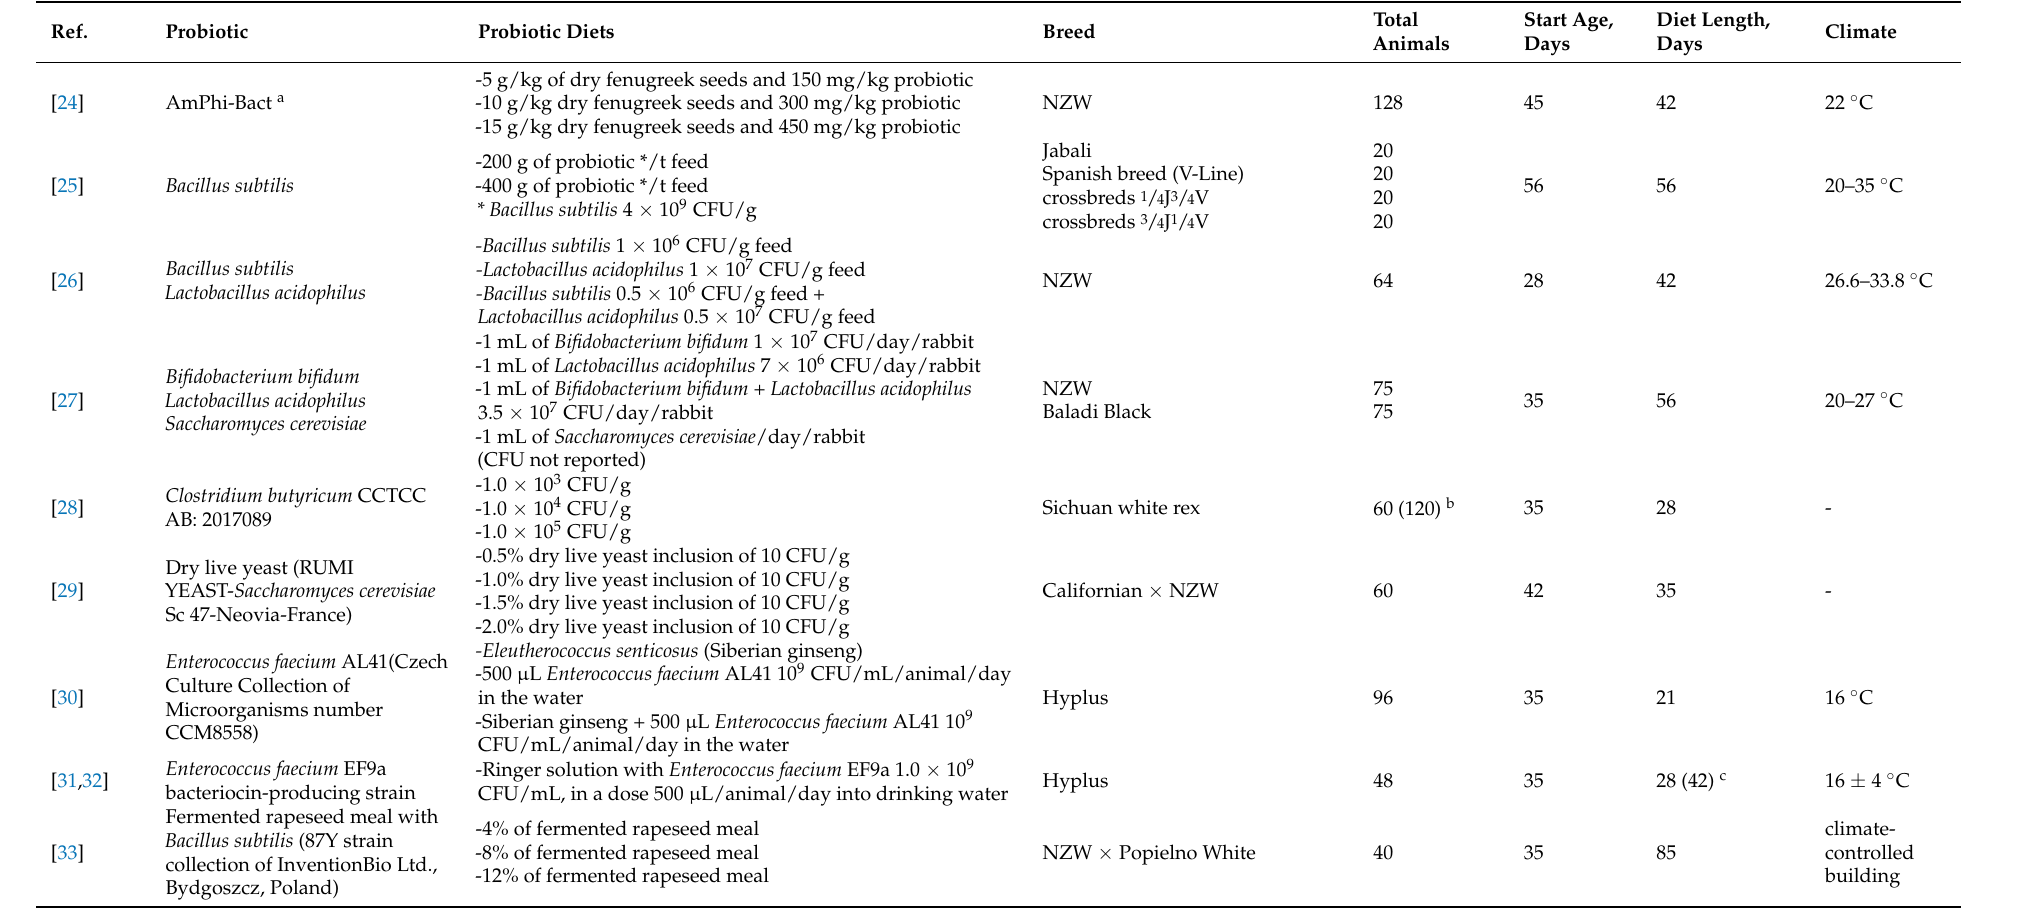
Table 1. Experimental designs of the reviewed